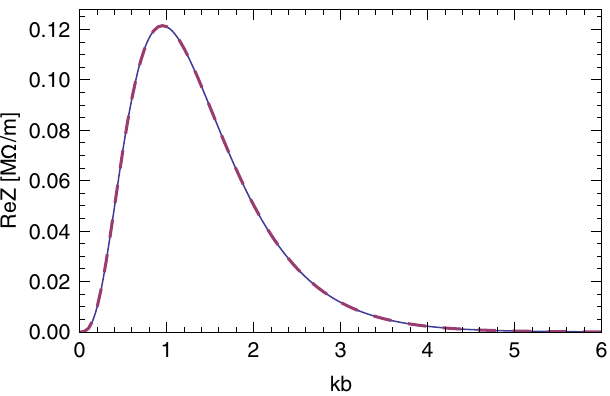
FIG. 6. Re ð Z Þ for beam passing by one, infinitely wide dechirper plate at a distance b ¼ 0 . 25 mm (blue). The analytical results, Eq. (29), are also shown (red dashes).